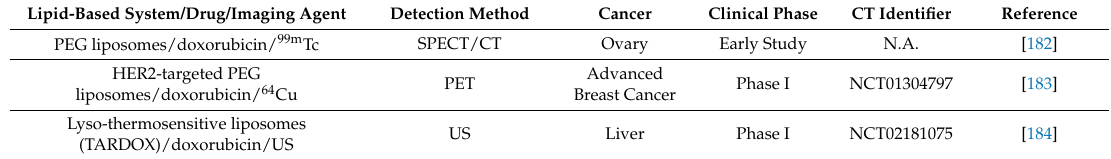
Table 3. Liposomal nanotheranostics in clinical studies for application in different malignancies. Lipid-Based System/Drug/Imaging